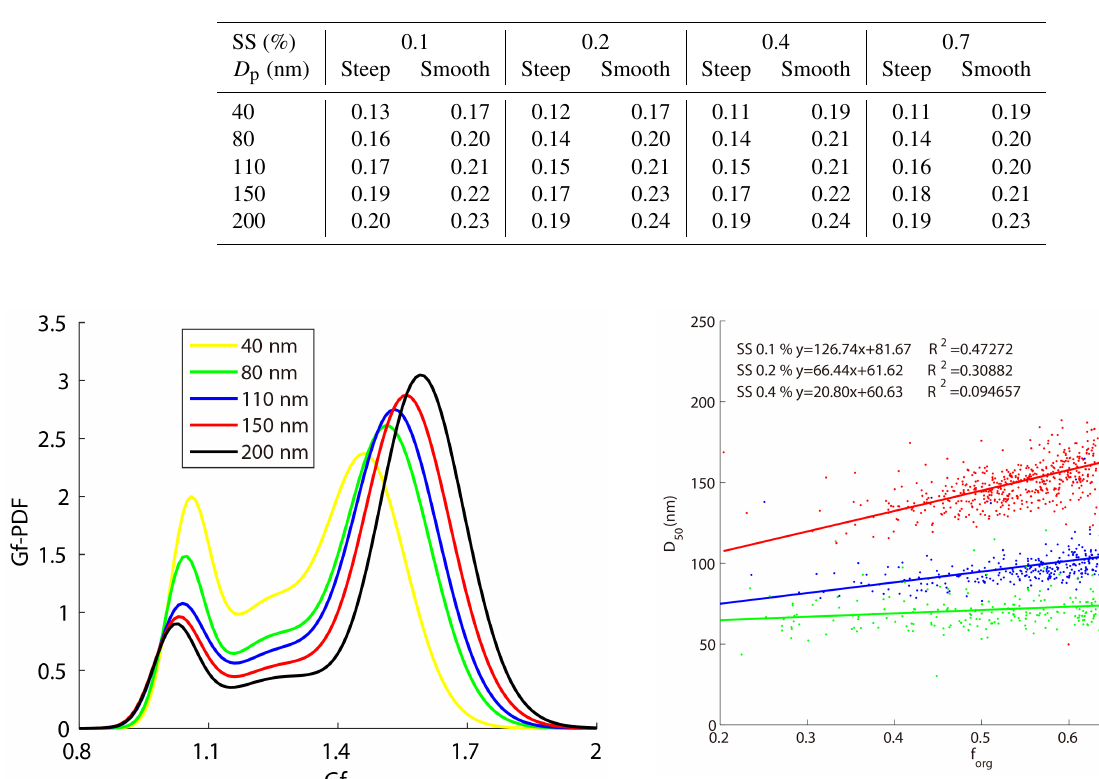
Figure 5. The Gf-PDF as a function of Gf measured by the HTDMA for the five diameters.